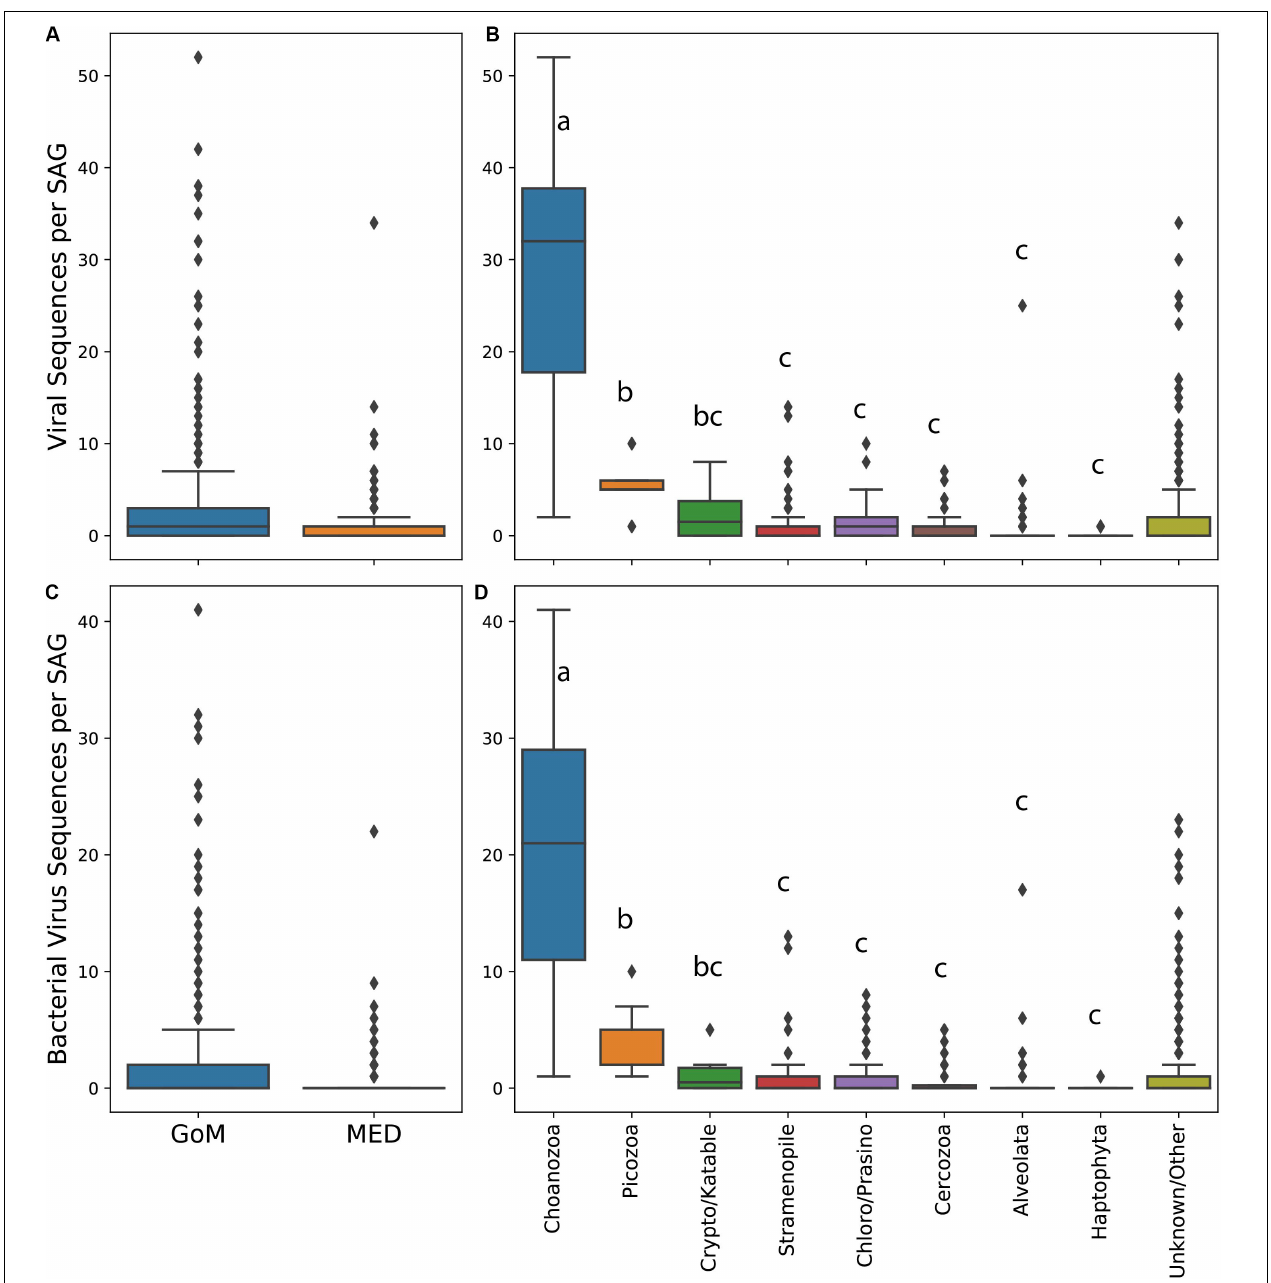
FIGURE 2 | Box and whisker plots of abundance of viral sequences in SAGs from the Mediterranean and Gulf of Maine (A) , abundance of viral sequences in different protist taxa (B) , abundance of bacterial virus sequences in SAGs from the Mediterranean and Gulf of Maine (C) , and abundance of bacterial virus sequences in SAGs from different protist taxa (D) . Lowercase letters in plots (B) and (D) indicate results of a post hoc Tukey test.